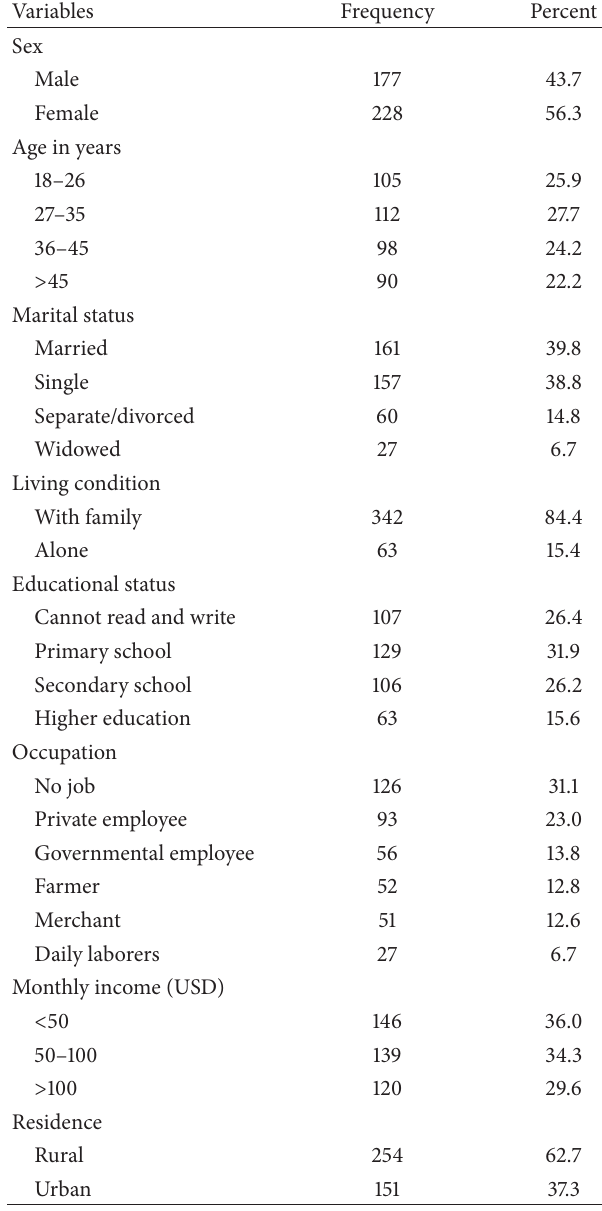
Table 1: Sociodemographic characteristics of adults with major depressive disorder (MDD) in University of Gondar and Felege Hiwot Referral Hospital ( 𝑛 = 405